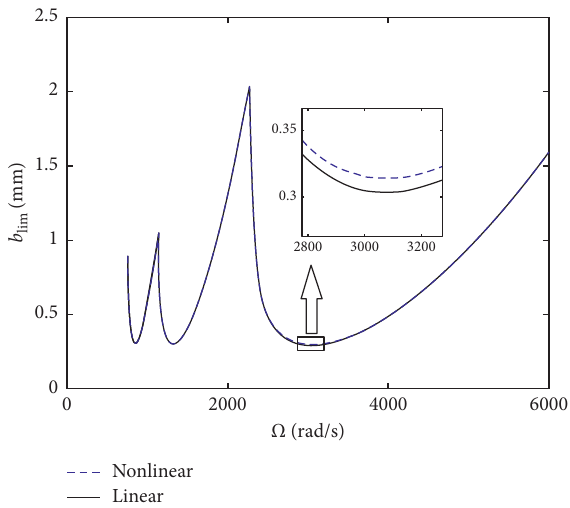
Figure 2: Lobes of the linear system of the nonextensible composite boring bar.